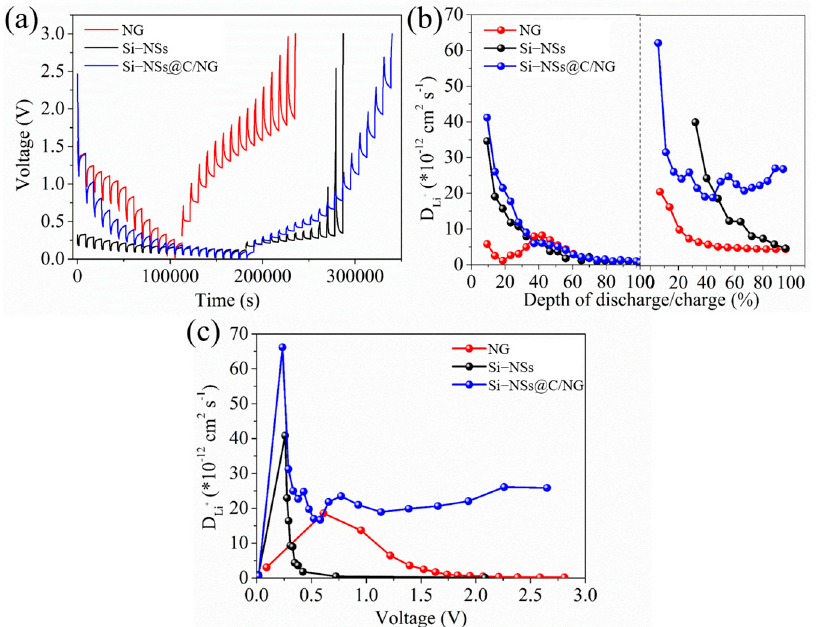
Figure 6. ( a ) GITT curves of Si–NSs, NG and Si–NSs@C/NG electrodes and ( b ) corresponding lith- ium ion di ff usion coe ffi cients; ( c ) lithium ion di ff usion coe ffi cients of active electrodes at di ff erent